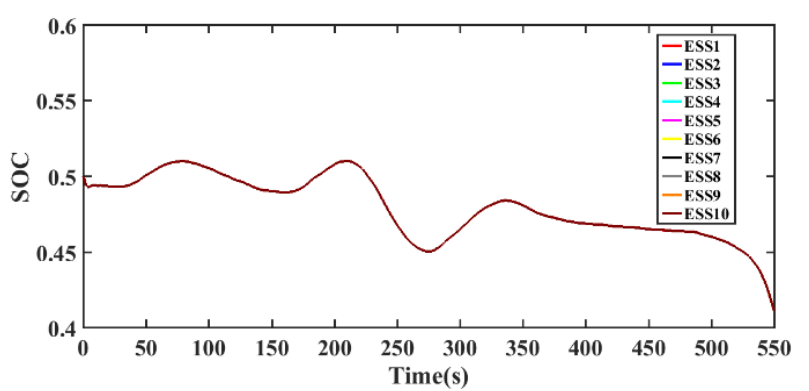
Figure 18. SOC of ESSs.